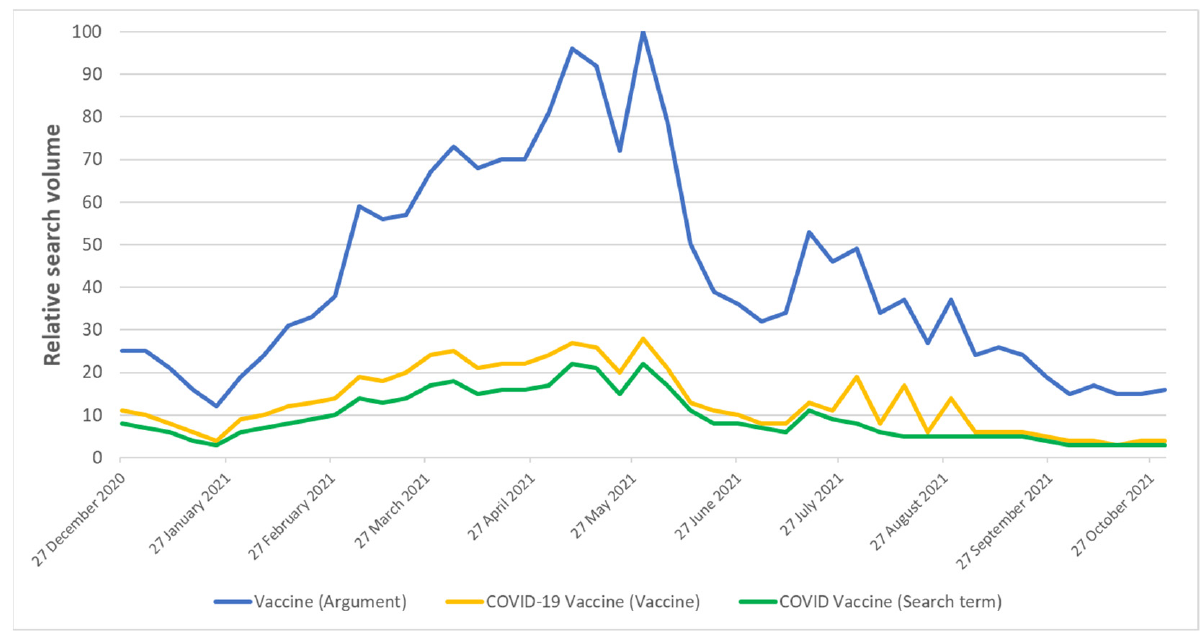
Figure 1. Comparison of the search interest for keywords Vaccine (Argument), COVID-19 Vaccine (Vaccine) and COVID Vaccine (Search term).